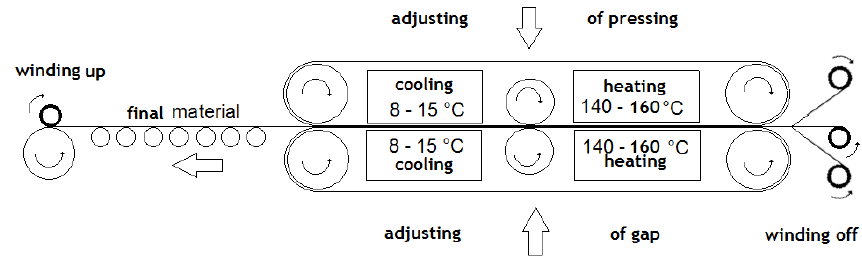
Figure 9. Scheme of lamination equipment used in the PROTEC company.